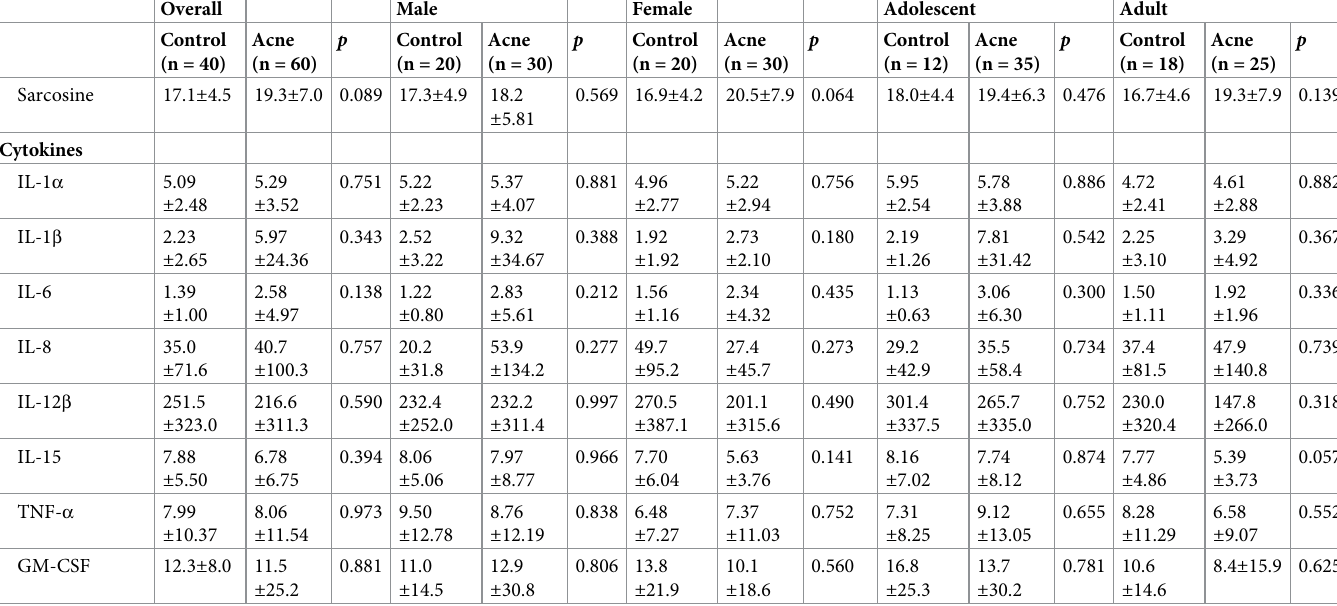
Adult subgroup. No significant differences were found in androgens, serum lipids, and cytokines. Five EAAs, two NEAA, sum of EAAs, and sum of NEAAs significantly lower, while two NEAAs were significantly higher in the acne group (Table 4 and Fig 1).